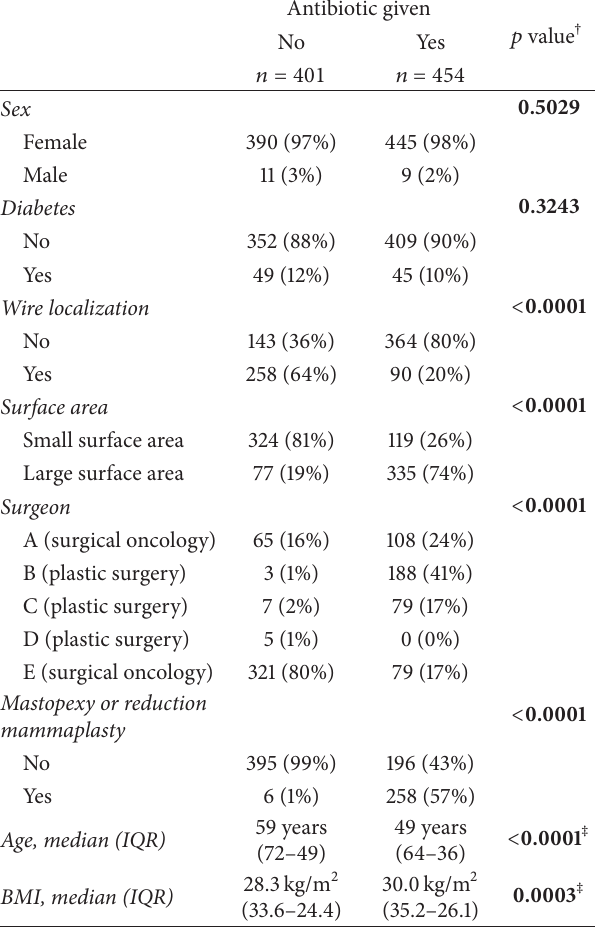
Table 2: Clinical characteristics and outcomes of the patient